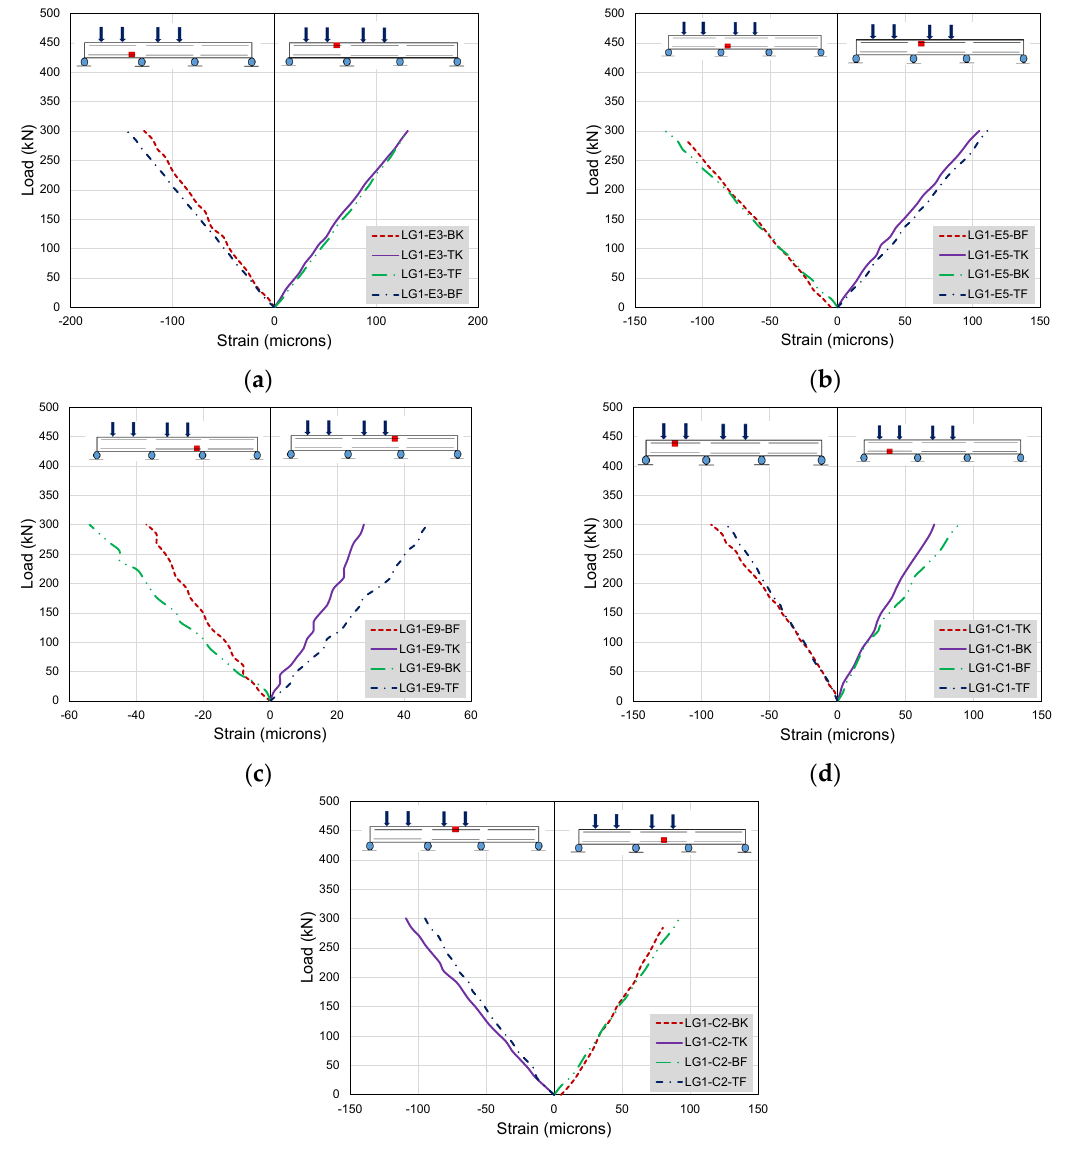
Figure 17. Strain versus load responses at locations ( a ) E3, ( b ) E5, and ( c ) E9, ( d ) C1, and ( e ) C2.